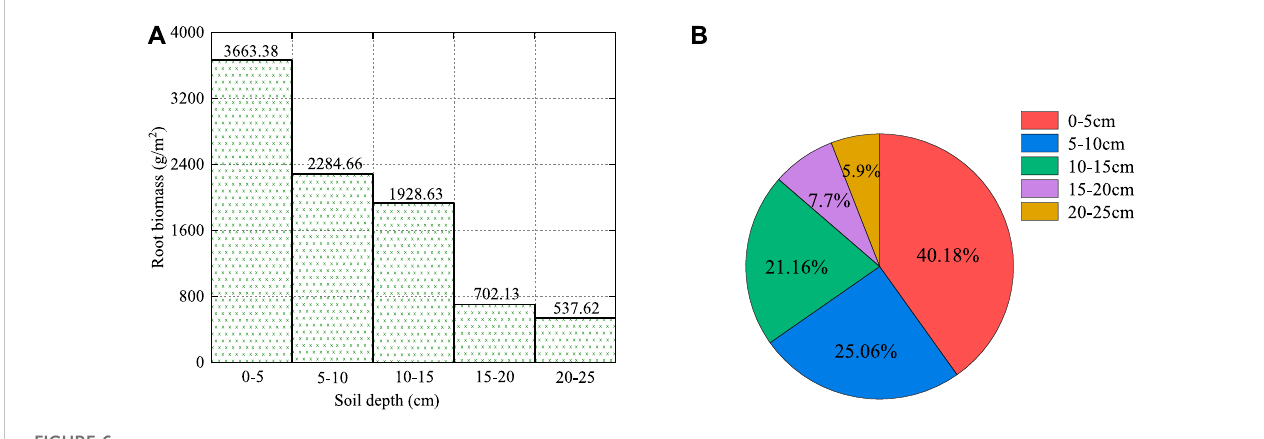
FIGURE 6 Root biomass and proportion of soil at different depths.